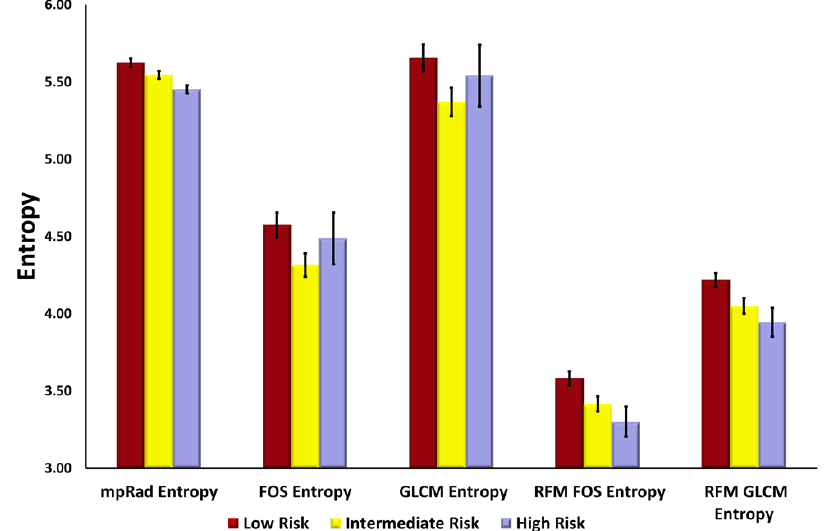
Figure 4. Bar graphs of different mpRad and single parameter entropy features extracted from DCE-MRI. Multiparametric radiomics (mpRad), Frist Order Statistics (FOS), Gray Level Co-occurrence Matrix (GLCM), radiomic feature mapping (RFM).